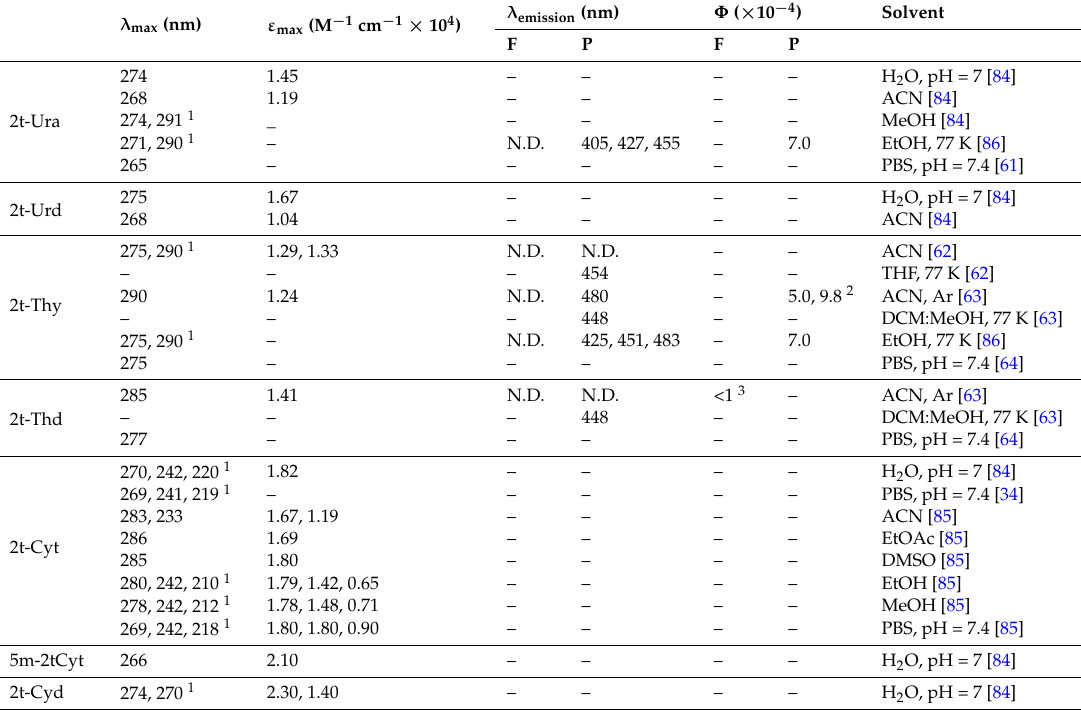
Table 4. Steady-state absorption and emission properties of 2-thiopyrimidine derivatives at room temperature unless otherwise indicated. F: Fluorescence; P: Phosphorescence; N.D.: Not detected.